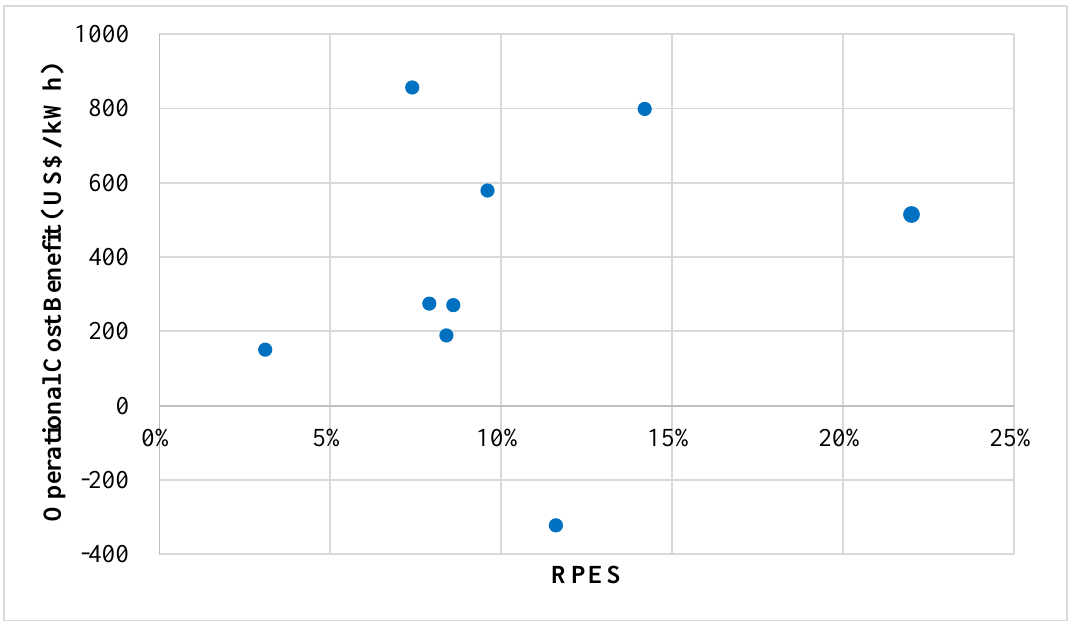
Figure 2. Relationship between RPES and operational cost – benefits for the investigated cases.